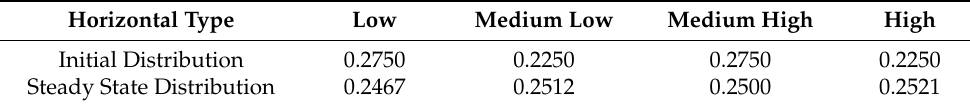
Table 4. Initial distribution and steady distribution probability of GTFP of grain in Poyang Lake